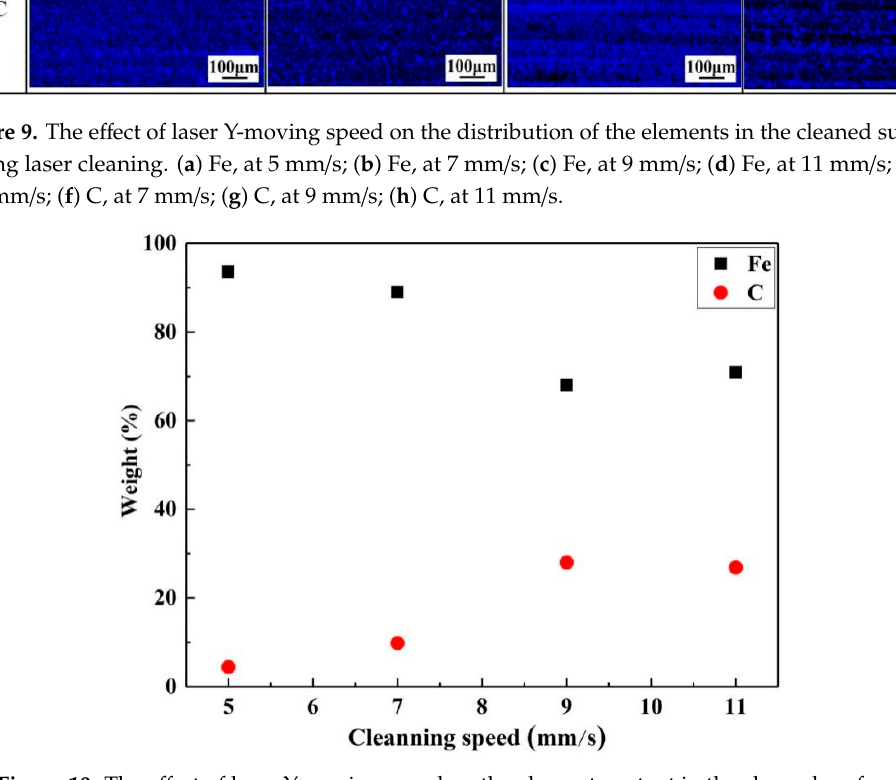
ff ect of laser Y-moving speed on the element content in the cleaned Figure 10. The effect of laser Y-moving speed on the element content in the cleaned surface. Figure 10. The e